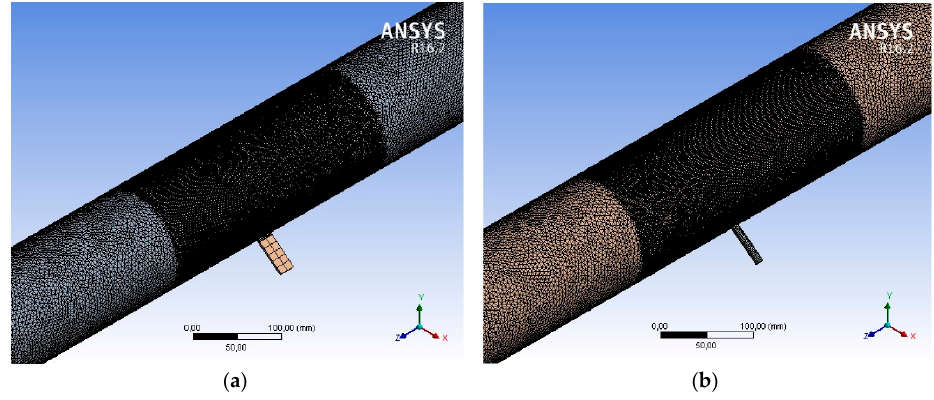
Figure 5. Computational Fluid Dynamics (CFD) modelling of a ( a ) rectangular orifice with longitudinal orientation and ( b ) circular orifice in Ansys environment.